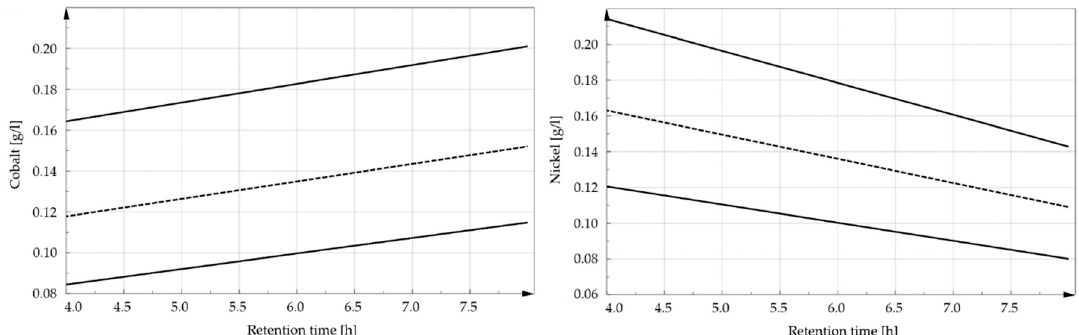
Figure 7. Behavior of soluble cobalt and nickel as a function of retention time (solid lines indicate the upper and lower confidence intervals, while the dashed line reflects the predicted values according to the